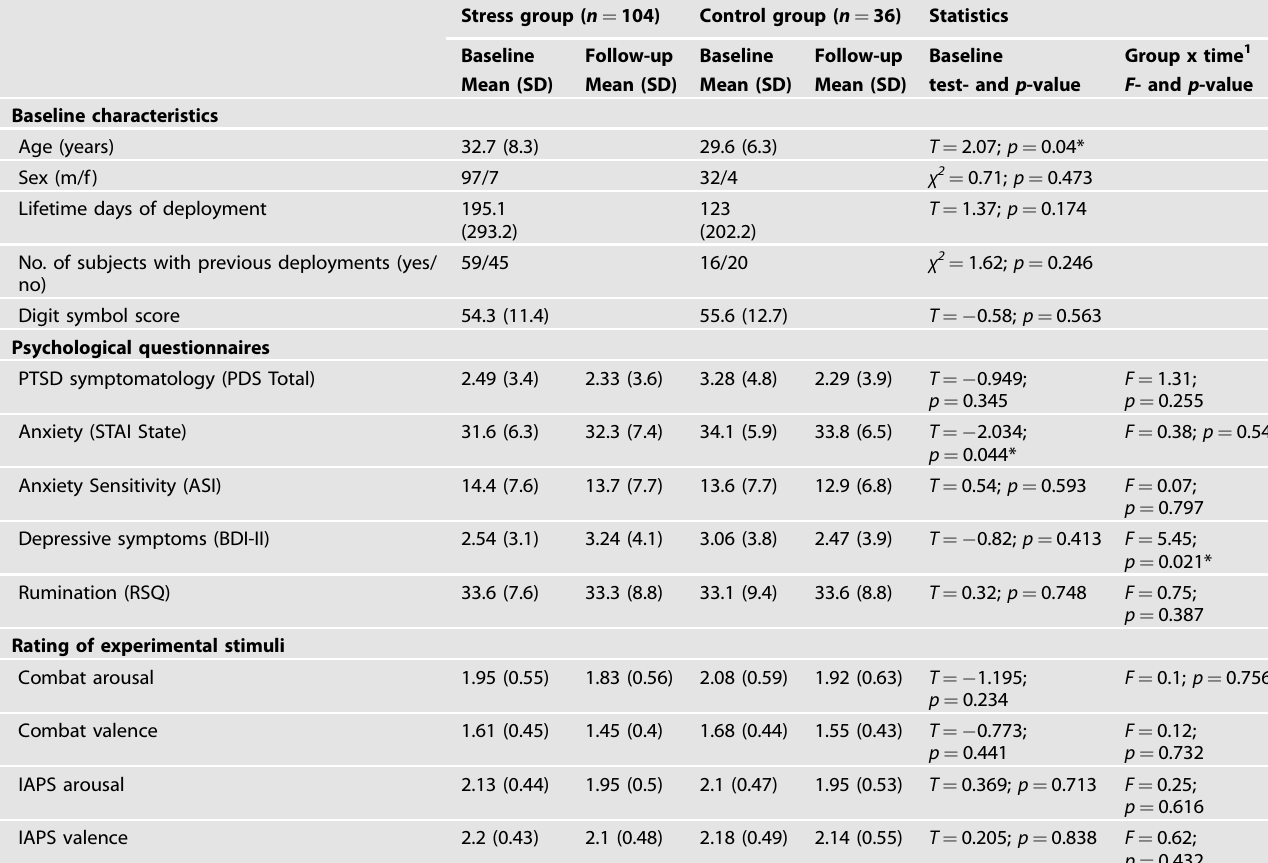
Table 1. Characteristics of the investigated sample at baseline (upper rows), change in clinical questionnaires across groups and time, rating of the experimental stimuli across groups and